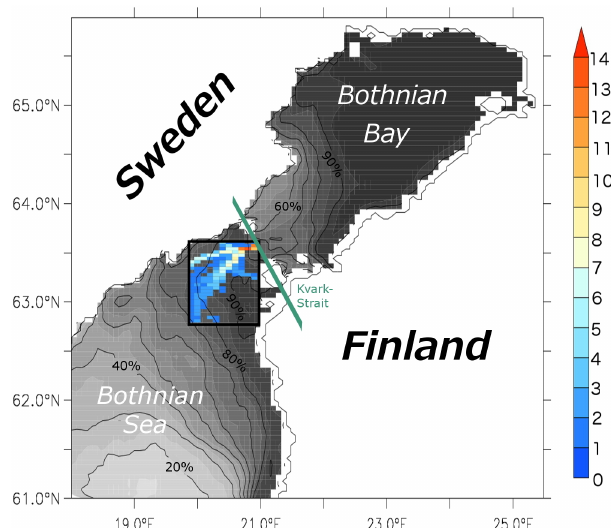
Figure 1. The test region considered in this study is indicated by the black box. Blue shading refers to the average number of ships in the test region per day and 3 × 3nm ( = 5556 × 5556m) model grid box in winter 2011 (January–April). Gray shading and contour lines depict the average ice concentrations in percent during that winter (SMHI forecast). Contour intervals are